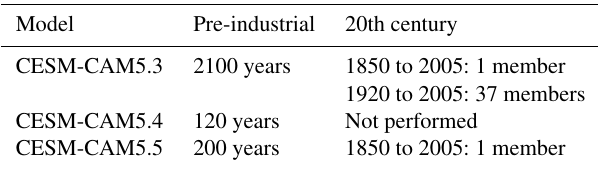
Table 2. Summary of coupled simulations performed. Model